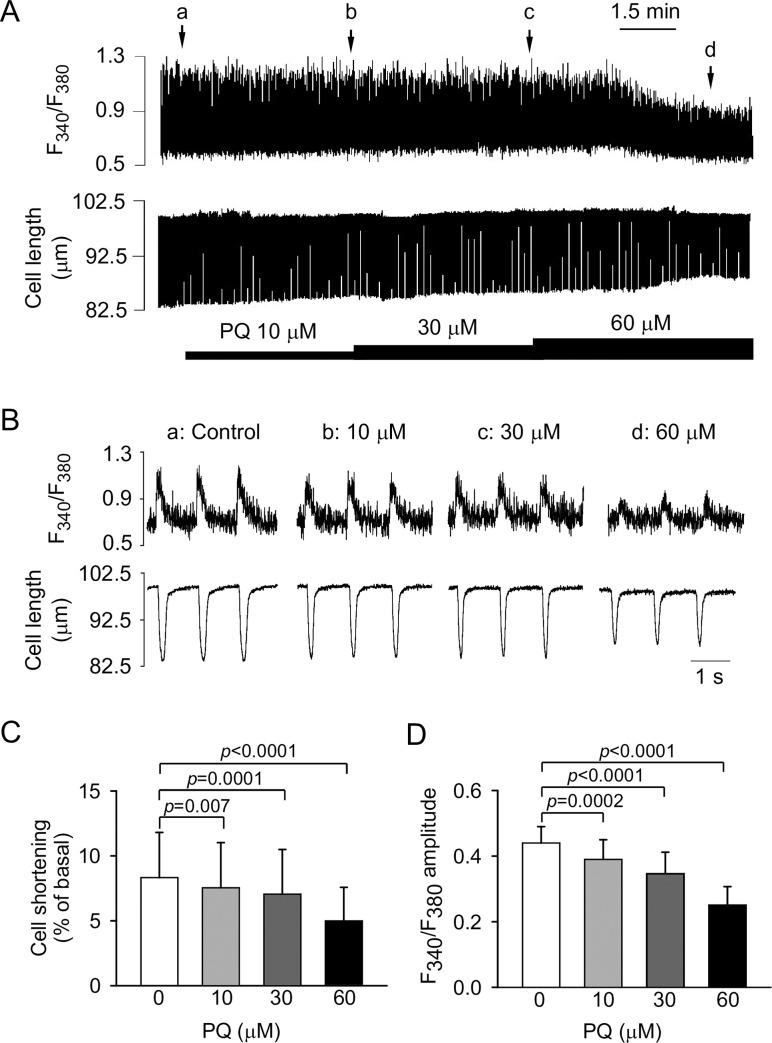
Effects of PQ on Ca2+ transients (represented by fura-2 fluorescence ratio F340/F380) and cell shortening in rat ventricular myocytes paced at 1 Hz.(A) Continuous recordings of Ca2+ transients (upper panel) and cell shortening (lower panel) showing the effects of the cumulative application of 10, 30, and 60 μM PQ. (B) Recordings on an expanded time scale taken at the time indicated by the corresponding letters over the F340/F380 trace in A. (C, D) The mean data of the amplitude of cell shortening (C) and Ca2+ transient (D) before and after application of PQ. Data are expressed as mean ± SD (n = 11). Cell shortening was normalized to resting cell length.